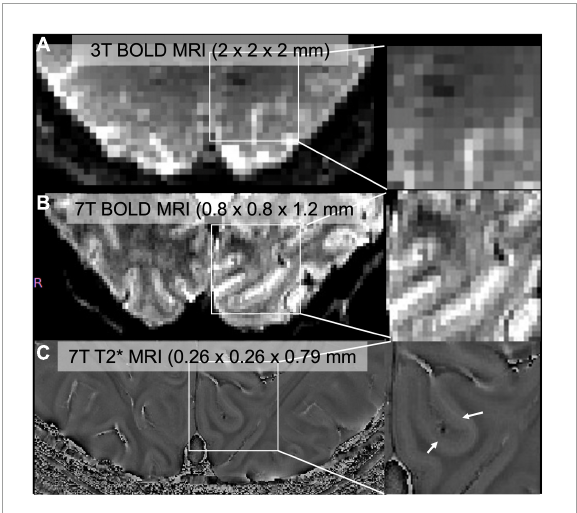
FIGURE1 (A) Standard resolution BOLD image through V1 collected at 3T (Siemens Prisma), (B) high-resolution BOLD image collected at 7T (Siemens Magnetom), (C) high-resolution T2* image. Zoomed images were shown in the right panel. We can identify a middle layer that corresponds to the stria of gennari (white arrows) in 7T but not in